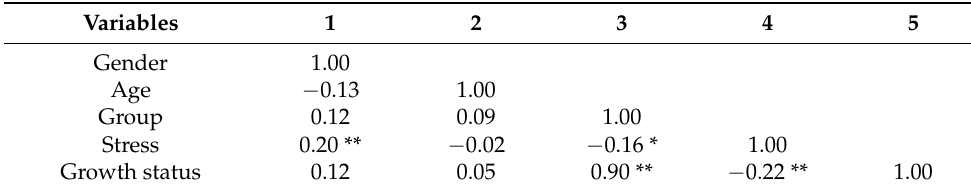
Table 2. Correlation matrix of variables.